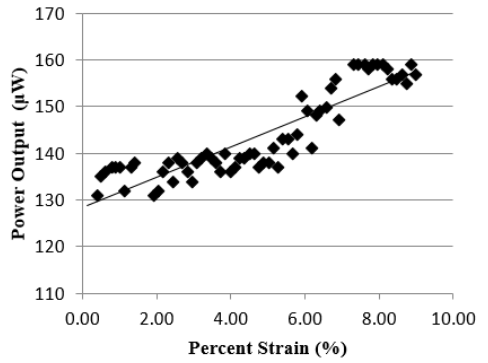
Figure 6. Power output versus power generator elongation. The initial experimental strain was set to 9%. We observed that starting from the strain of 8% the device output power was constant, with the value equal to 160 μW.